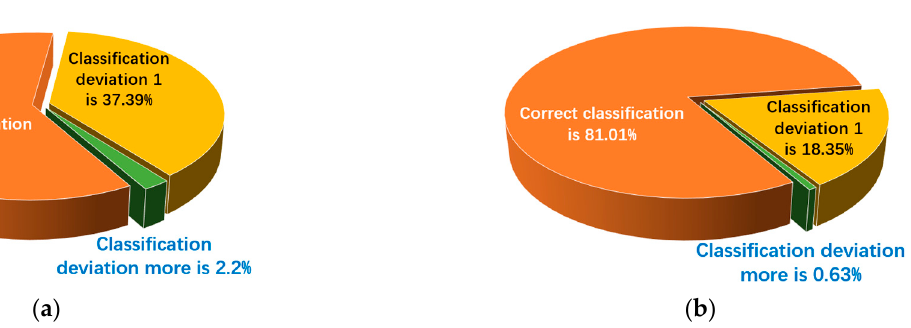
Figure 3. The accuracy of the mixing ratio classification fitting: ( a ) 24,000 enhanced data statistics; ( b ) 480 raw data statistics.